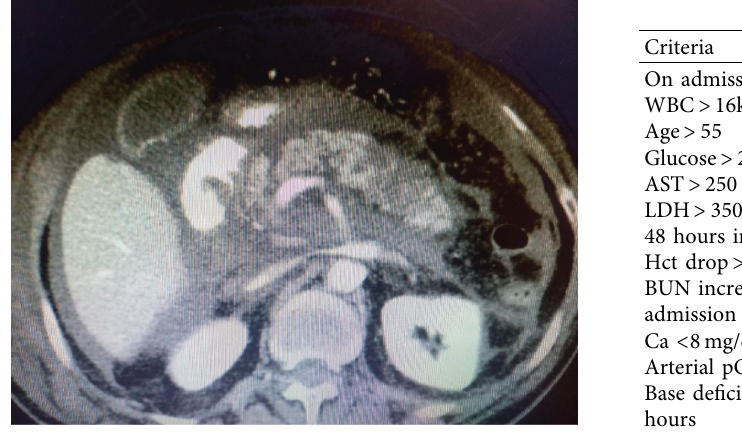
Figure 3: Computed tomography scan of the abdomen showing necrotic areas (hypoenhancing, nonenhancing) in the body of the pancreas.